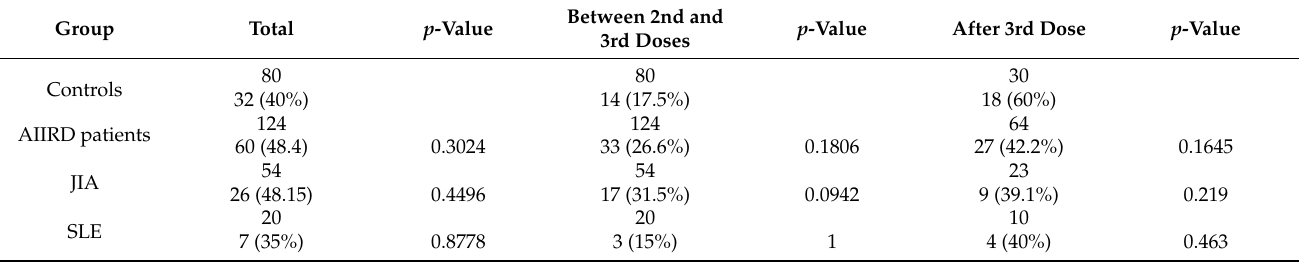
Table 3. COVID-19 infection events following vaccination among patients with AIIRDs compared with controls.